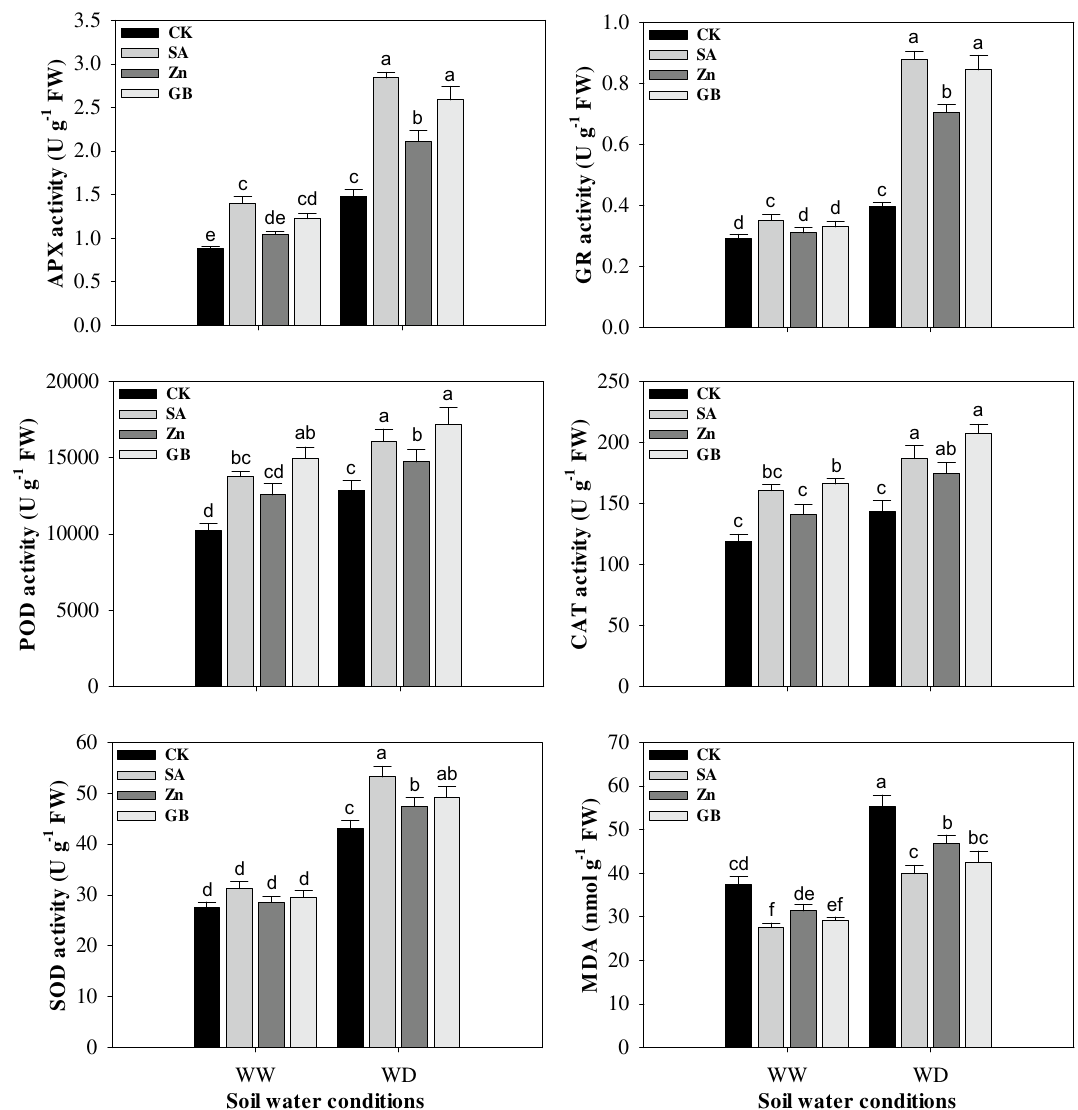
Figure 3. Effect of soil water conditions and foliar treatments on the activities of ascorbate peroxidase (APX), glutathione reductase (GR), peroxidase (POD), catalase (CAT) and superoxide dismutase (SOD), and malonaldehyde (MDA) content. Every column in each graph represents the mean (± SE) of three replicates. Different letters above columns indicate that means are different at 95% confidence level. WW, well-watered; WD, water-deficient; CK, control (double distilled water); SA, salicylic acid; Zn, Zinc; GB, Glycine